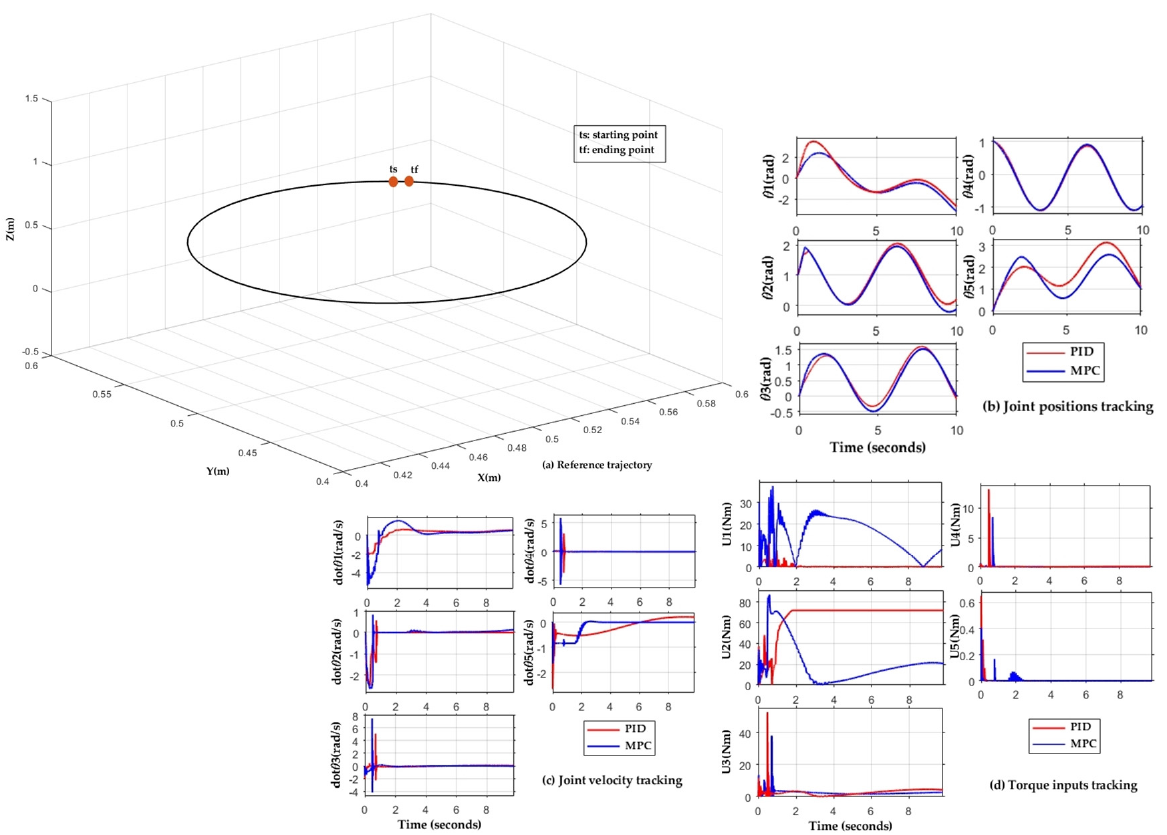
Figure 12. Simulation results related to the circle reference trajectory.